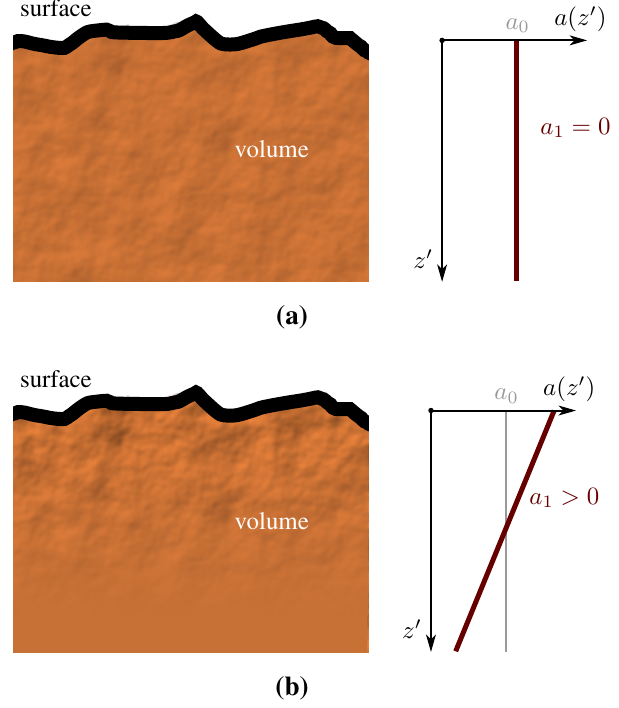
Figure 2. Illustration of the depth dependence of the dielectric fluctuations a p z 1 q of Equation (16) for the parametric functions with A “ 0 (constant, top panel) and A “ 1 (linear dependence, bottom panel). In the left-hand diagrams, the graininess of the soil corresponds to the magnitude of the dielectric fluctuations, whose spatial variation is shown on the right. ( a ) A “ 0 ; ( b ) A “ 1